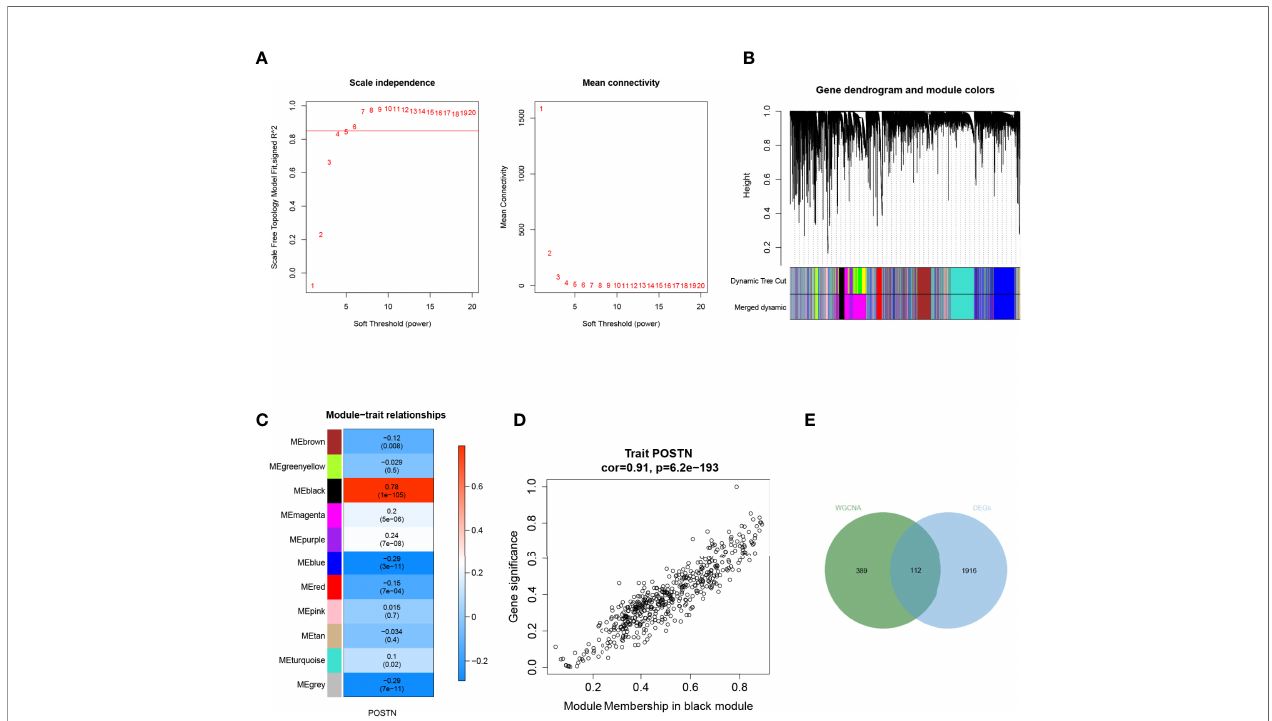
FIGURE 4 | Weighted gene correlation network analysis. (A) Soft threshold screening. The horizontal axis of the graph represents the weight parameter power value, and the left vertical axis represents the scale-free fi t index, namely, signed R 2 , the higher the square of the correlation coef fi cient, which shows that the network was closer to the scale-free distribution. The vertical axis of the right graph represents the mean of all gene adjacency functions in the corresponding gene module. (B) Module merging. Genes were divided into modules through hierarchical clustering, and different colors represent different modules. A total of 11 co- expressed modules were acquired using the dynamic cut-tree algorithm. (C) Heat map of the relationship between the module and trait. The black module displayed the highest correlation with POSTN . (D) Correlation analysis of the gene with module and POSTN in microenvironment black module. (E) Screening of POSTN- related differentially expressed genes (DEGs), which yielded a total of 112 genes that were recognized as POSTN -related-hub